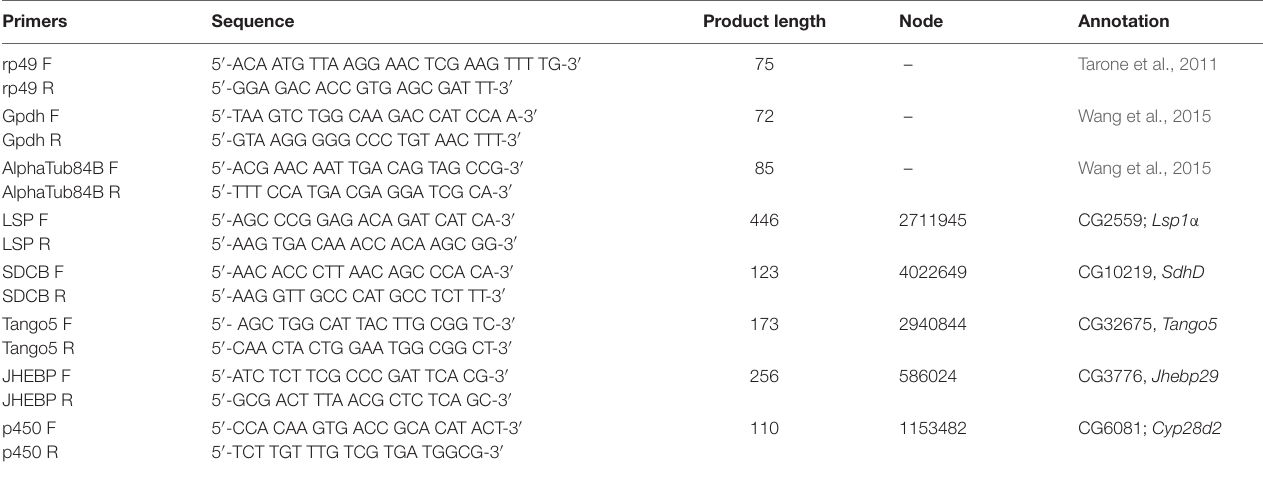
TABLE 4 | Validation primer sequences and expected PCR product